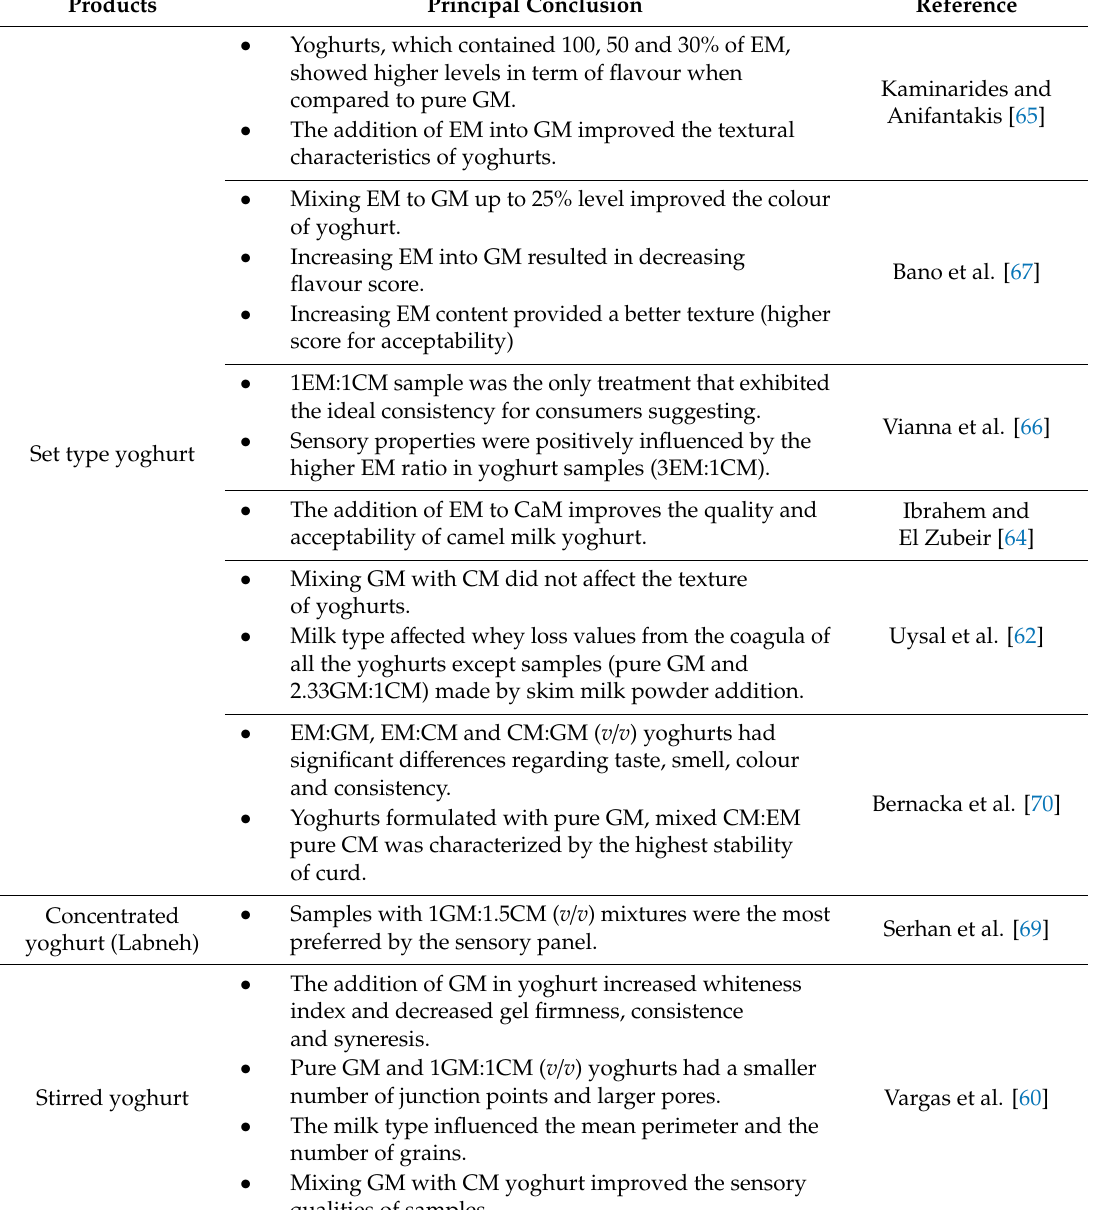
Table 6. Examples of principal conclusions of studies concerning the e ff ect of mixing milk from di ff erent species at di ff erent proportions on rheological and sensory properties of